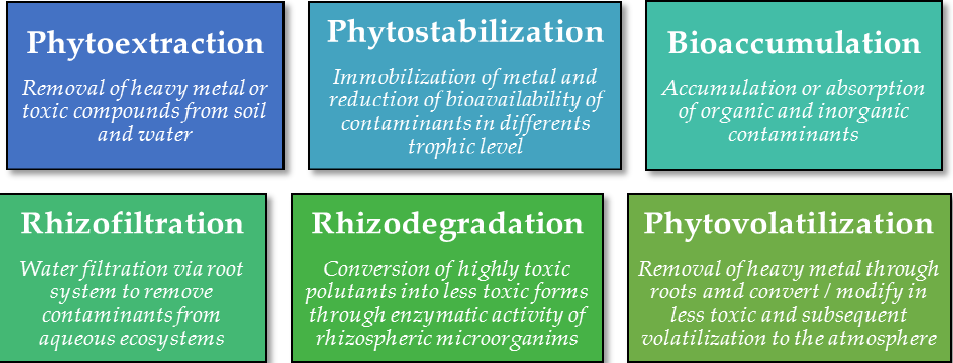
Figure 1. Bio- and phytoremediation approaches involving endophytic fungi.